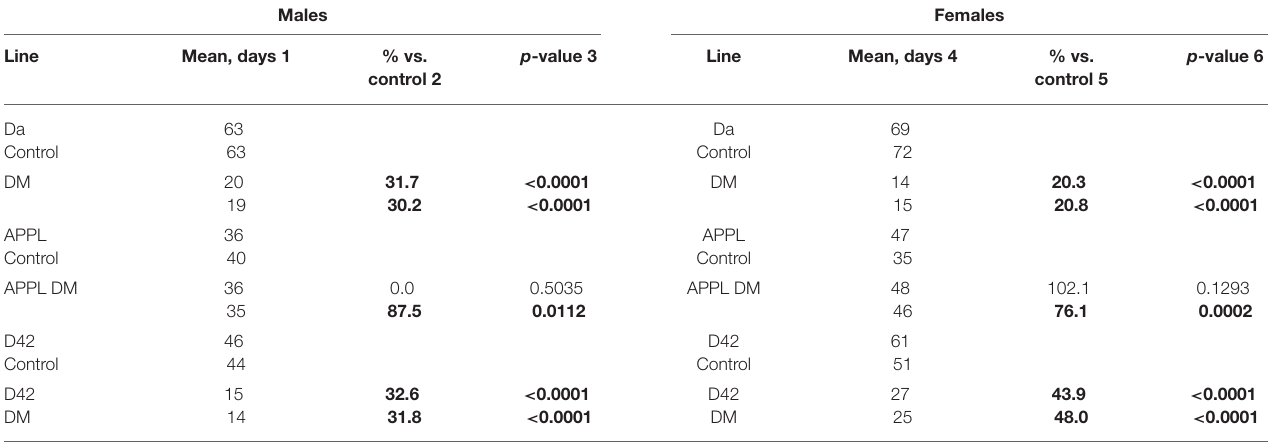
TABLE 2 | Mean life span of the double-mutant flies under-expressing dPrx3 in dprx5 null mutant background shown in Figure 1 . Males Females Line Mean, days 1 % vs. control